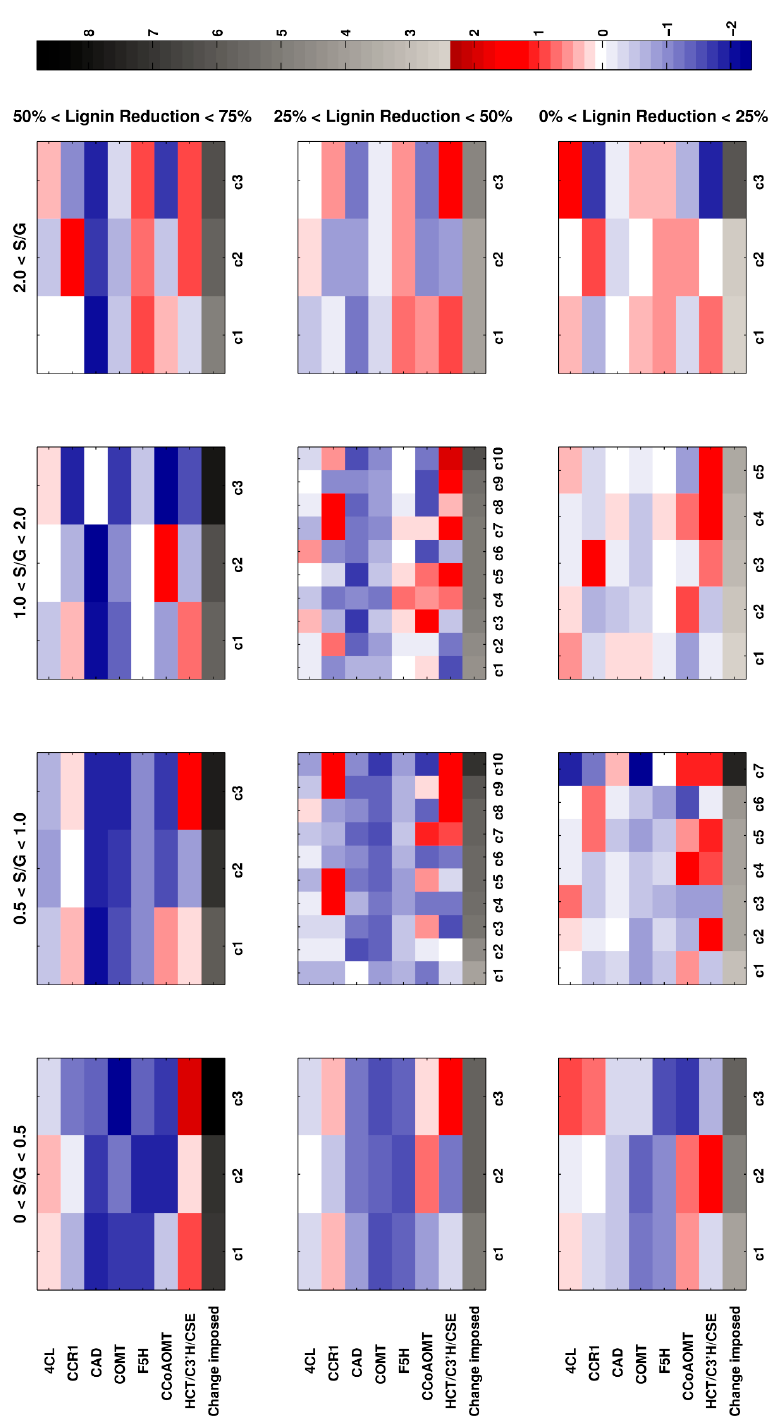
Figure 8. Global perturbation scenarios. All seven enzymes are perturbed simultaneously. The results are broken into 12 subpanels. The subpanels in the same columns share the same S/G ratio, and the subpanels in the same row share the same total lignin. Each of the subpanels includes several columns, where each column represents a cluster of perturbation vectors that are sorted based on the distance from the wild type. Cluster c1 in each subpanel is the closest perturbation scenario to the wild type. The grey scale represents the distance from the wild type, and the red/blue spectrum shows the increase/decrease in pathway enzyme. White represents the wild type, therefore, no change in the enzyme.